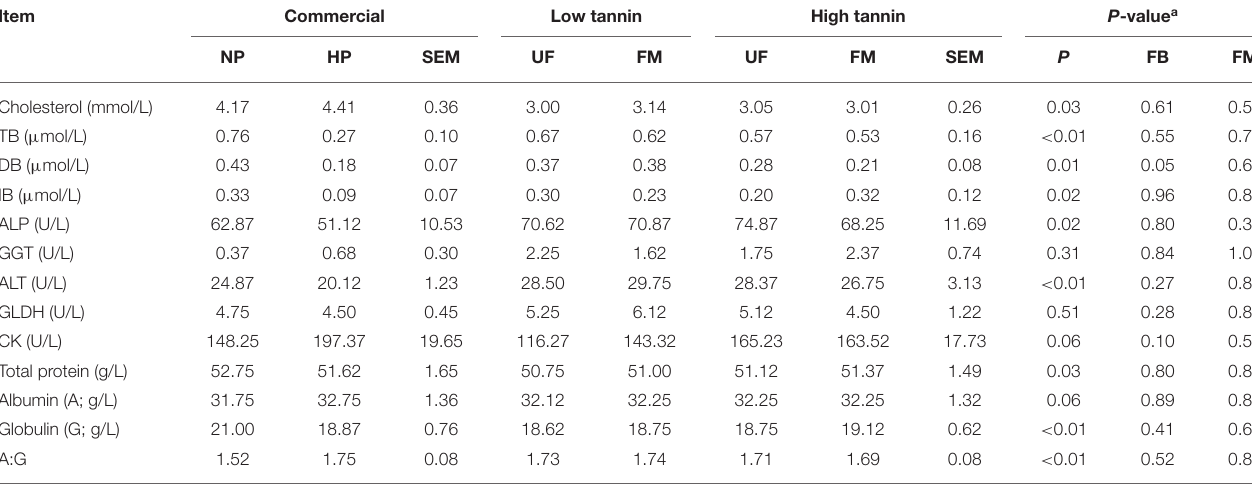
TABLE 3 | Blood parameters of hepatic function in dogs fed diets formulated with either low or high tannin fava beans without (UF) or with (FM) fermentation, or normal (NP) vs. high (HP) protein commercial diets for 7 days each * .